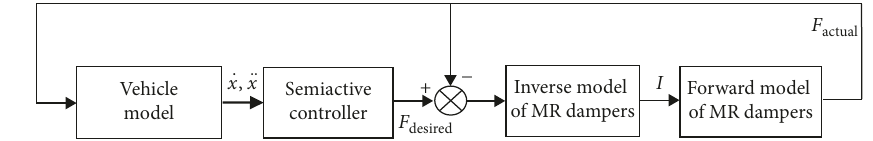
Figure 16: Structure of the semiactive suspension system model.